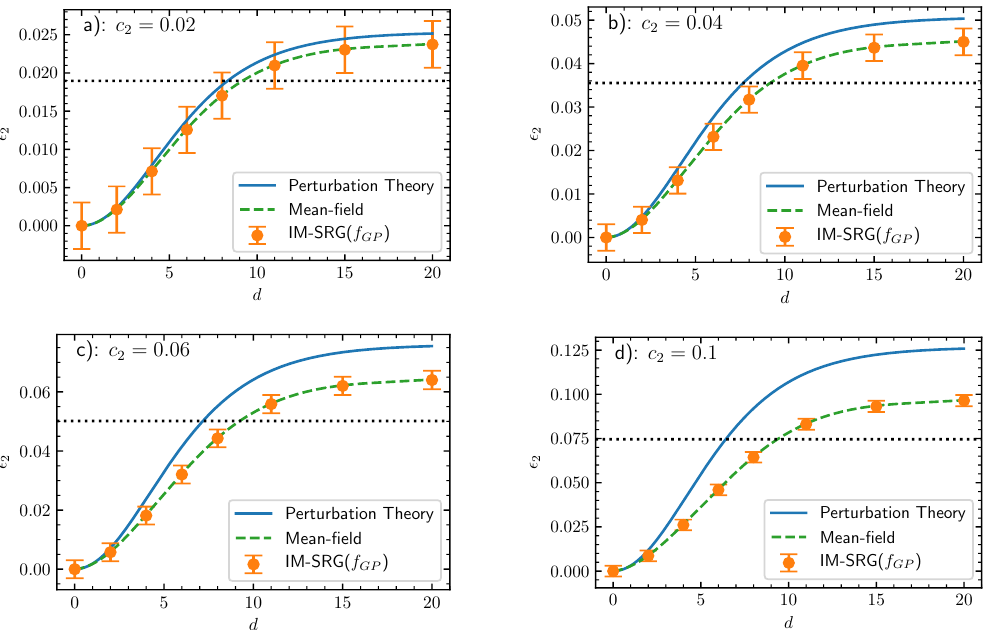
Figure 7: The impurity-impurity interaction induced by the Bose gas for repulsive > 0. Dots with error bars represent the IM-SRG( f boson-impurity interactions, c 2 results. The solid (blue) curves are calculated using perturbation theory, and the dashed (green) curves show the mean-field energy. The data are for N = 60, γ = 0.02 and four different values of the boson-impurity interaction: a) c = 0.04, c) c = 0.06, and d) c = 0.1. For comparison, the dotted lines b) c 2 2 2